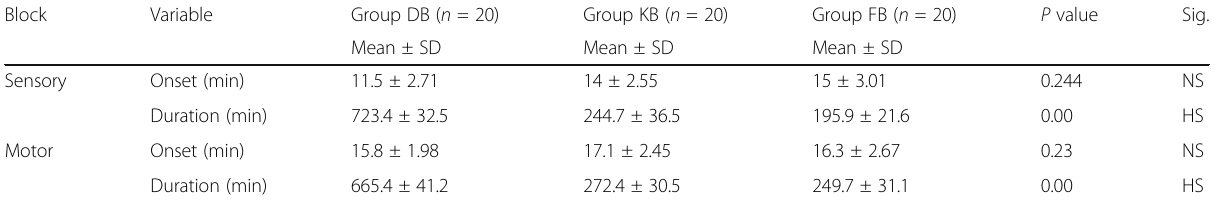
Table 1 Sensory and motor block onset and duration Block Variable Group DB ( n = 20)